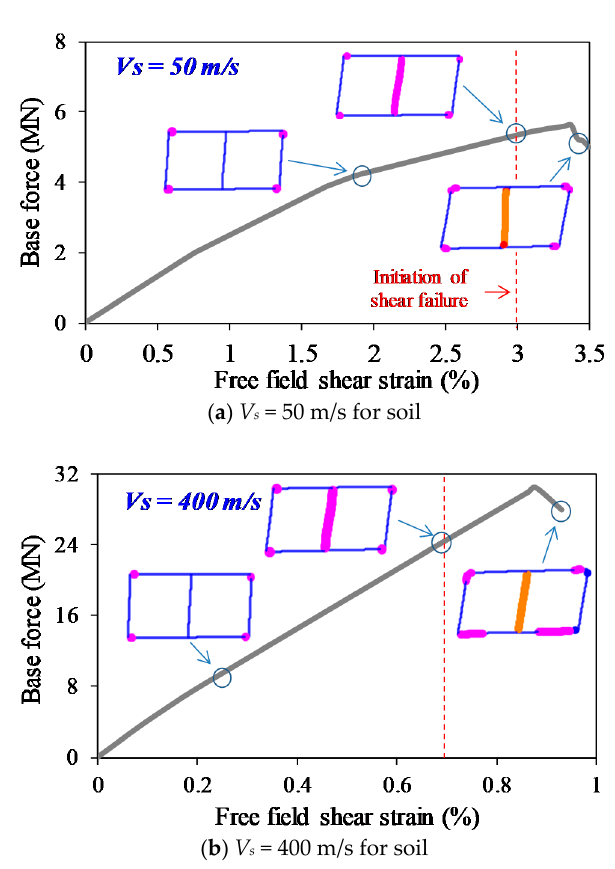
Figure 5. Development of plastic hinges for double box with the width to height ratio (B/H) = 1.0